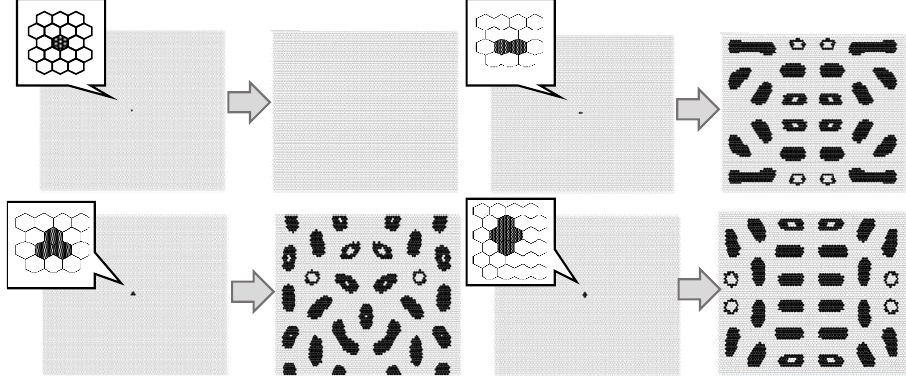
Figure 13. Results with the initial condition of state 1 under the same conditions as in Figure 12 ( s = 4, t = 8, w 1 = 0.40, and w 2 = 0.75 in a hexagonal grid). If there is only one state 1 in the initial field, Rule 4 was applied at that location, which disappeared at the next step. If there are two or more state 1s as the initial state, state 1 was observed to survive, and a pattern formation similar to Figure 12 occurred.